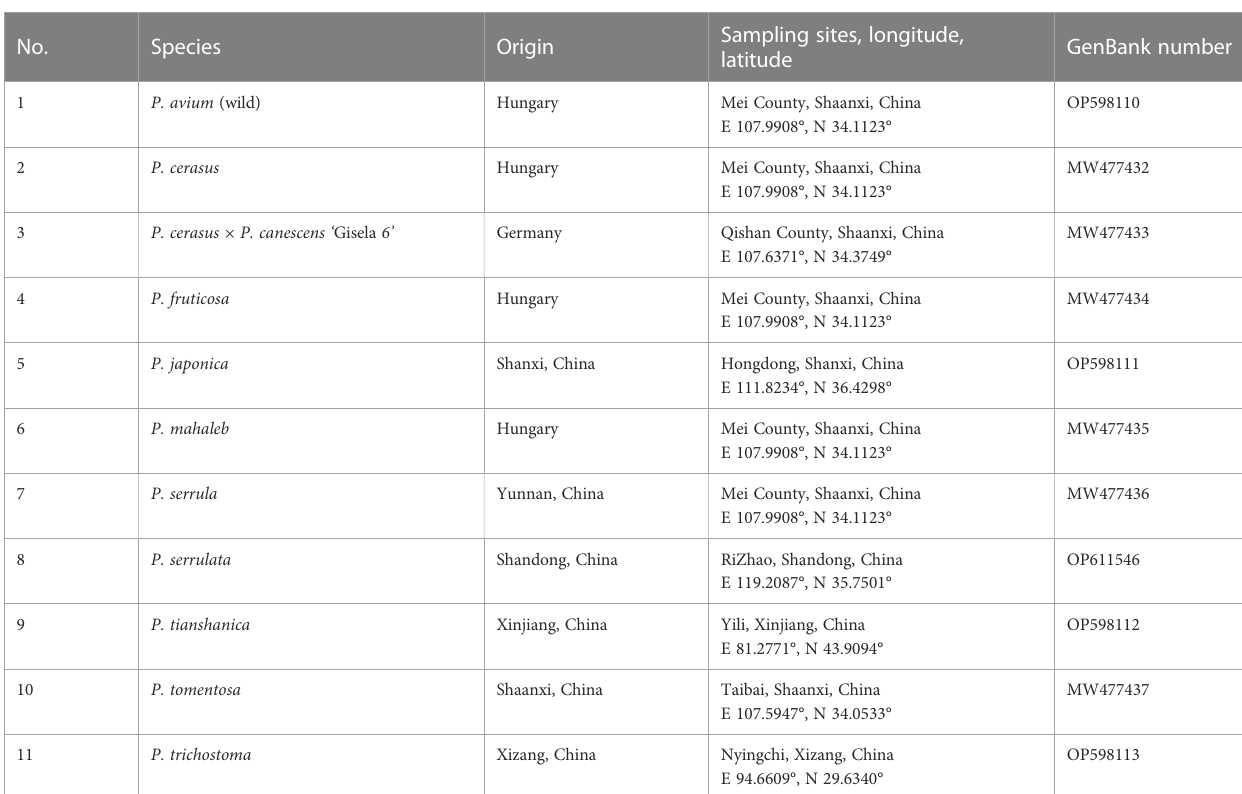
TABLE 1 Sampling information for the Cerasus